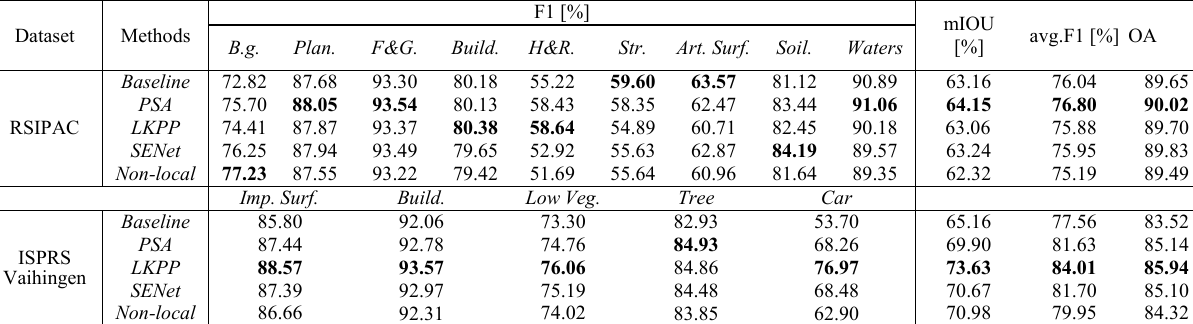
Table 7. Results of land cover classification using PSA and the state-of-art methods on the RSIPAC dataset and the ISPRS Vaihingen dataset. The baseline is ResNet152 . Best scores are in bold